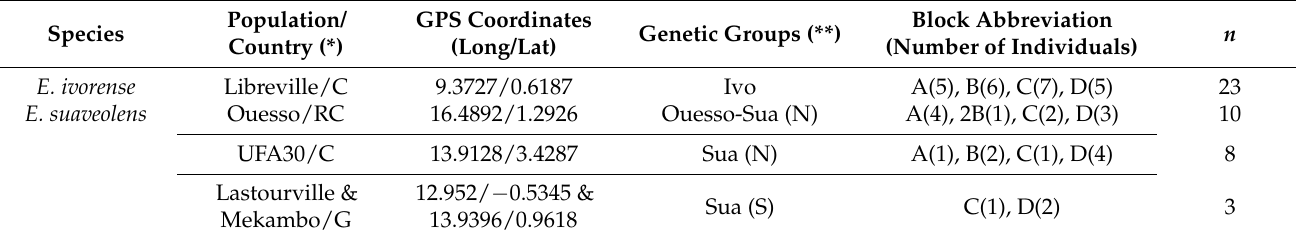
(*) C = Cameroon, RC = Republic of the Congo, G = Gabon; GPS coordinates correspond to locations of original populations. (**) Genetic groups based on microsatellite markers refer to the assignment of the different populations inside a larger genetic groups [10]. Ivo = ivorense ; SuaN = suaveolens central North, SuaS = suaveolens central South based on reference